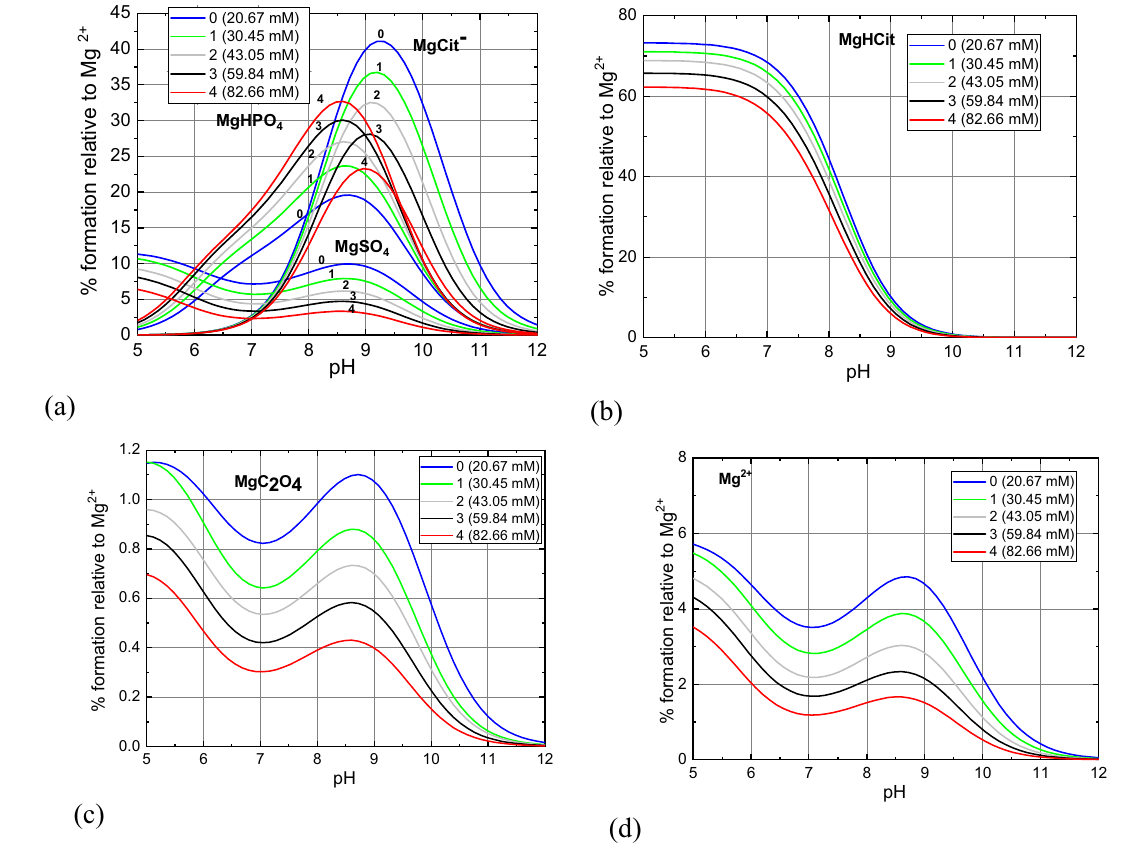
Figure 7. Percentage content of various Mg 2+ complexes ( a – c ) and free Mg 2+ ions ( d ) depending on pH of artificial urine for different P concentrations. The percentage content is given with respect to the initial concentration of Mg 2+ ion given in Table 5.